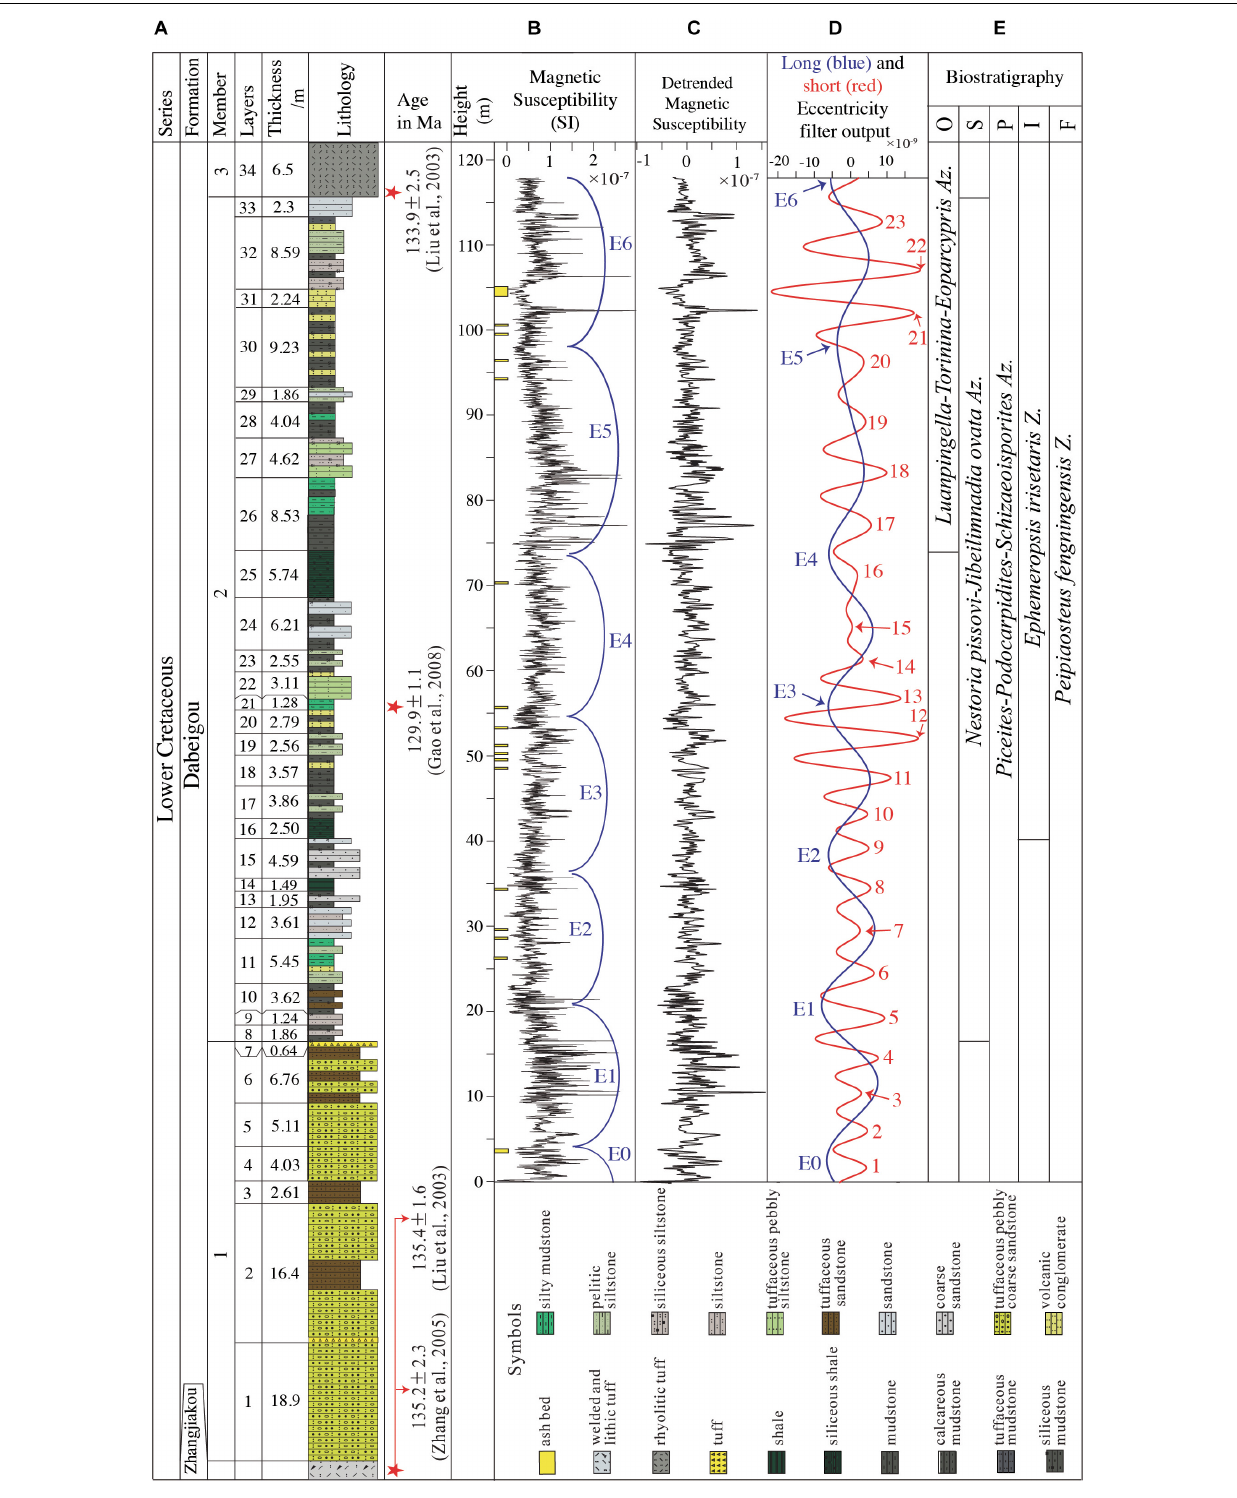
Frontiers in Earth Science |